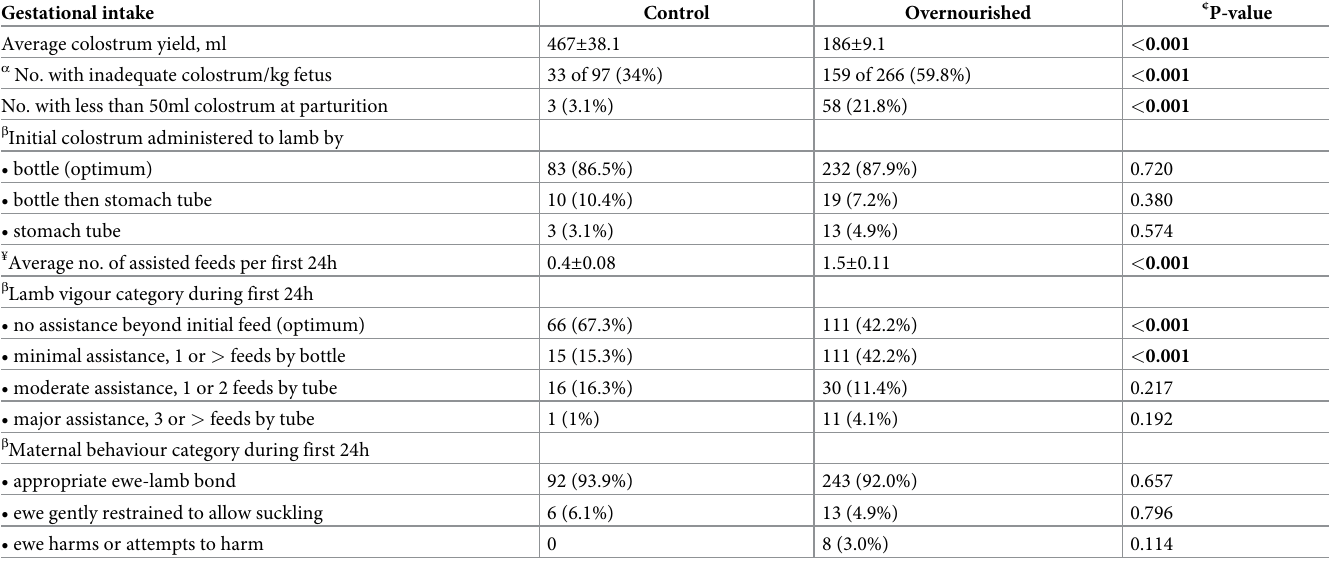
Table 3. Initial colostrum yield, lamb vigour and maternal behaviour during the first 24h after delivery in singleton bearing adolescent ewes offered a control intake or overnourished throughout